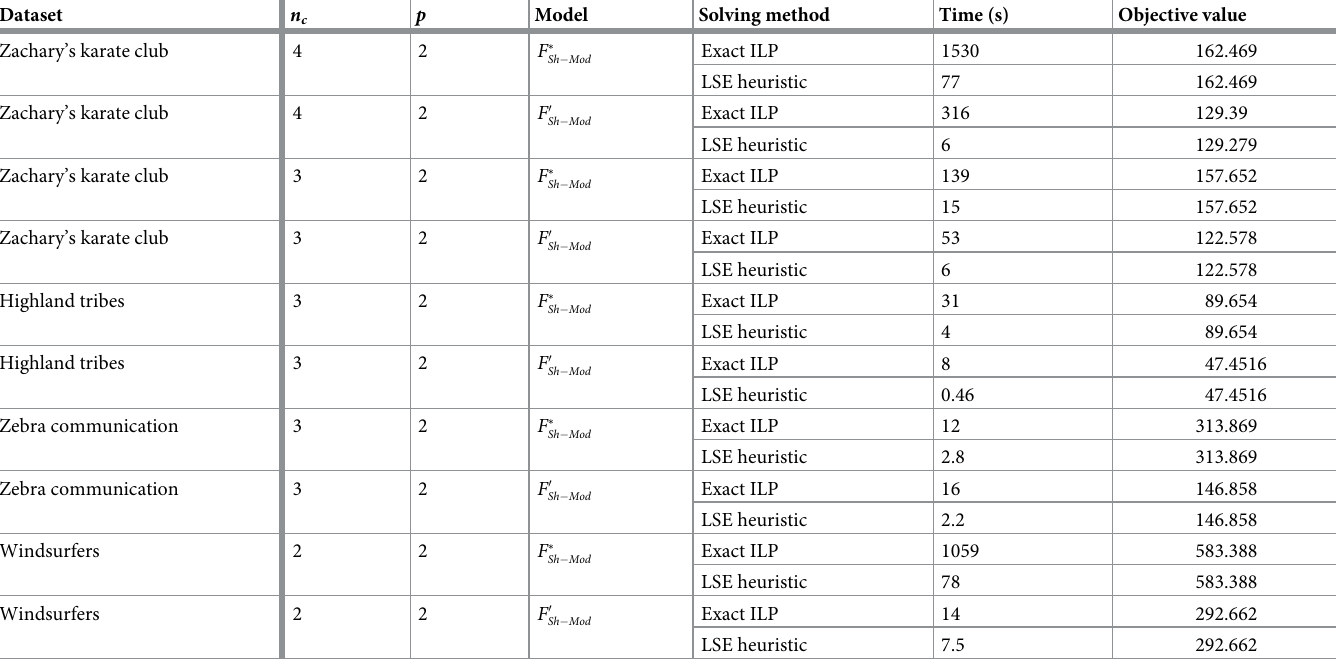
Table 1. Computational results of the solution